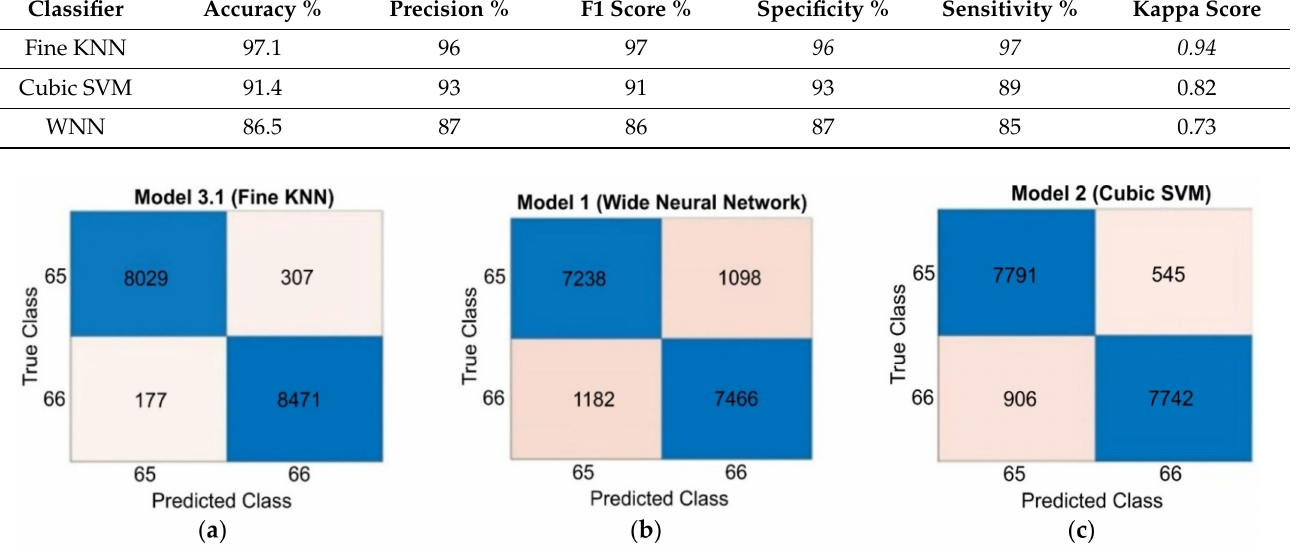
Figure 6. Confusion matrix on ten-fold validation. ( a ) Fine KNN; ( b ) WNN; ( c ) SVM-cubic.